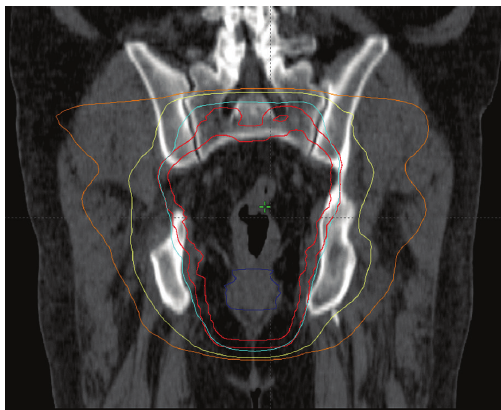
Figure 1: Coronal images of an IMRT plan.